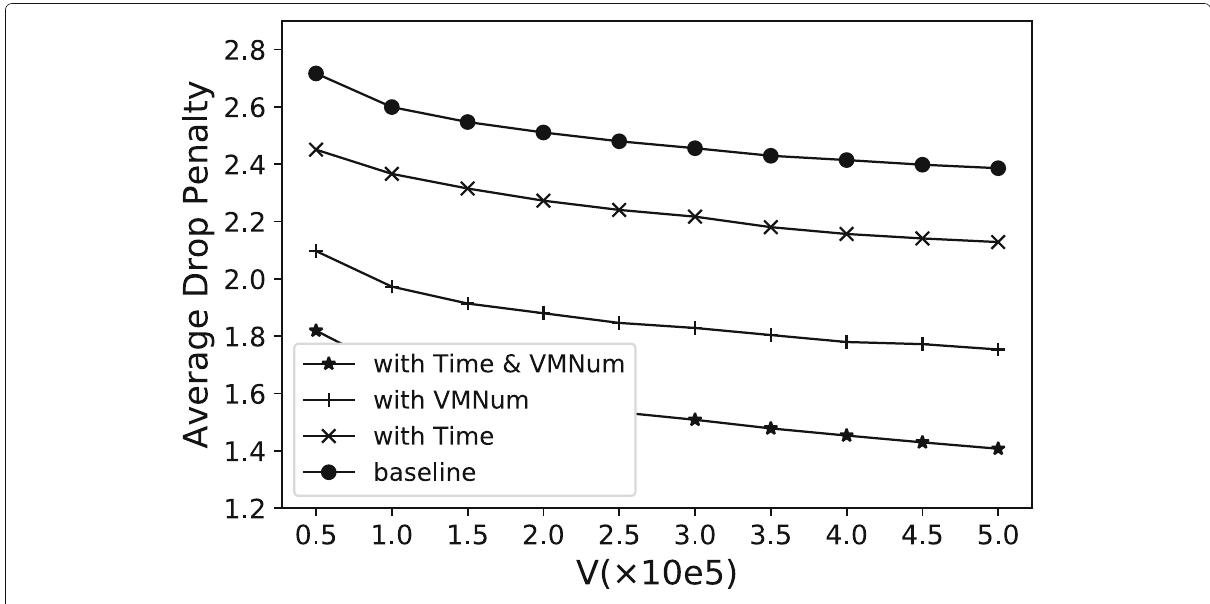
Fig. 8 Comparison of average drop penalty with different values of